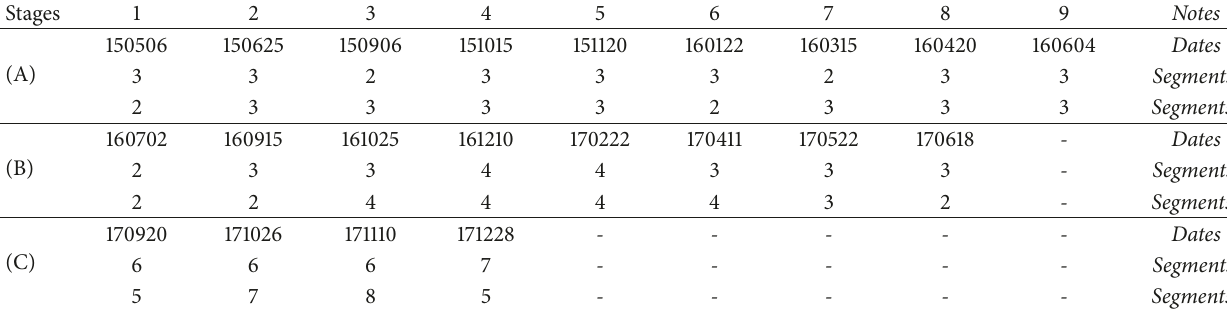
Table 4: Data collection dates of the 150 segments.